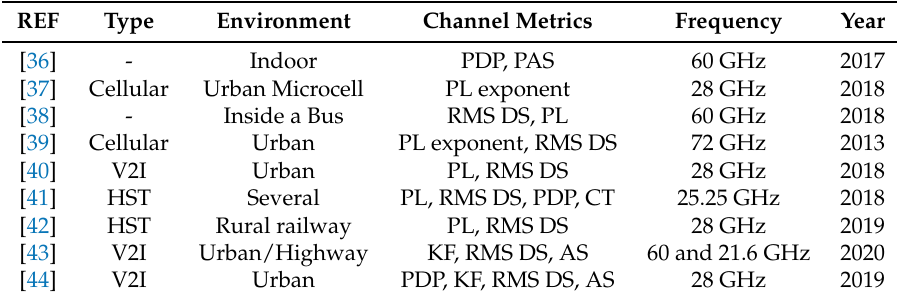
Table 1. RT/RL approaches for mmWave frequency